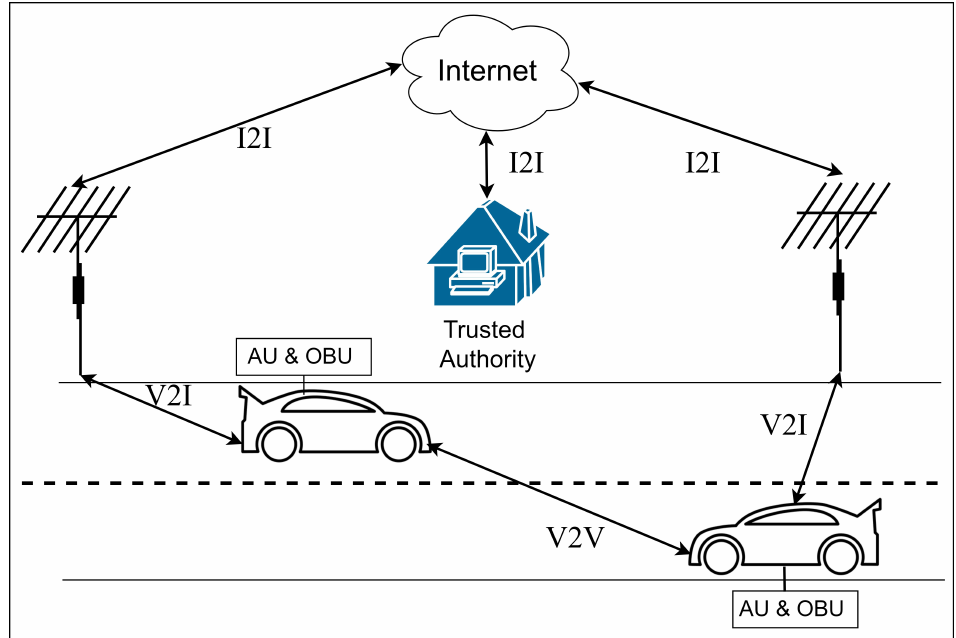
Figure 2. General architecture of